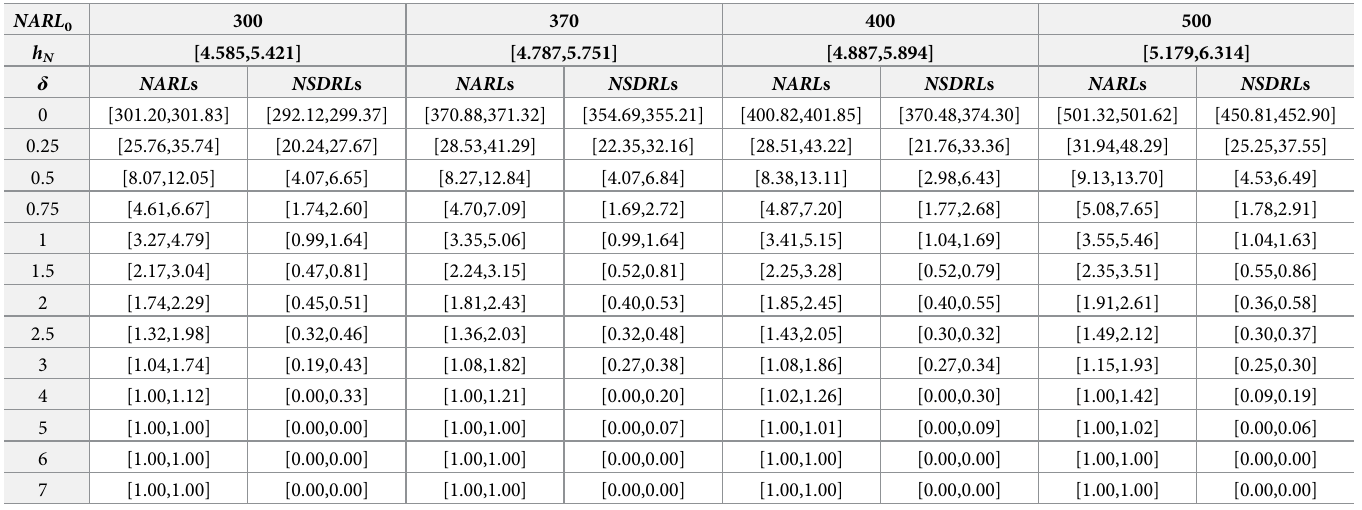
NARL 1 decrease until they approach a value of one, i.e. [1.00,1.00]. The latter implies that, for large values of δ , the control chart will give an out-of-control signal on the next sam- pling point. Similarly, the NSDRL s tend to zero for largest values of δ , i.e. [0.00,0.00], which means that the variability is reduced when δ values are large. 2. For a specified neutrosophic sample size, n , there is an increasing trend in NARL values 1 N as the neutrosophic value of k increase at small shifts of δ ; however, there is an decreasing N trend in NARL values for large shifts of δ (see Tables 1 and 2). For instance, when 1 ever, when k 2 [0.40,0.50], the NARL 2 [28.53,41.29] using the same parameters. Note 1 N value, the NARL is equal to [1.96,2.29] and [1.08,1.82] though, at δ = 3 for the same NARL 0 1